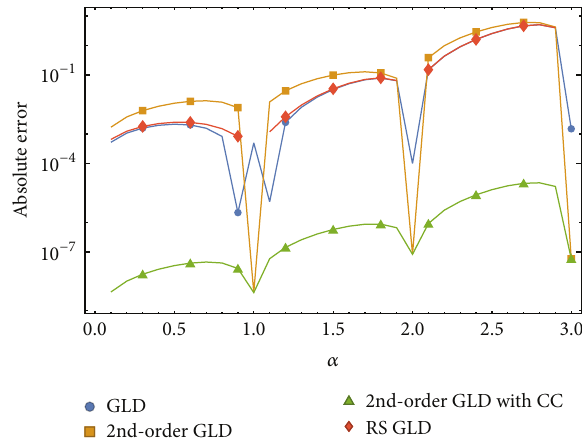
Figure 5: Absolute error over time domain for four different methods.